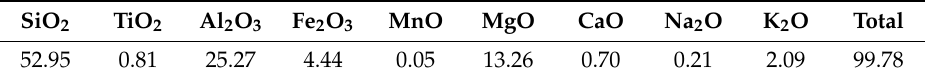
Table 1. Bulk chemical analysis of cordierite ceramic sample (CCS)